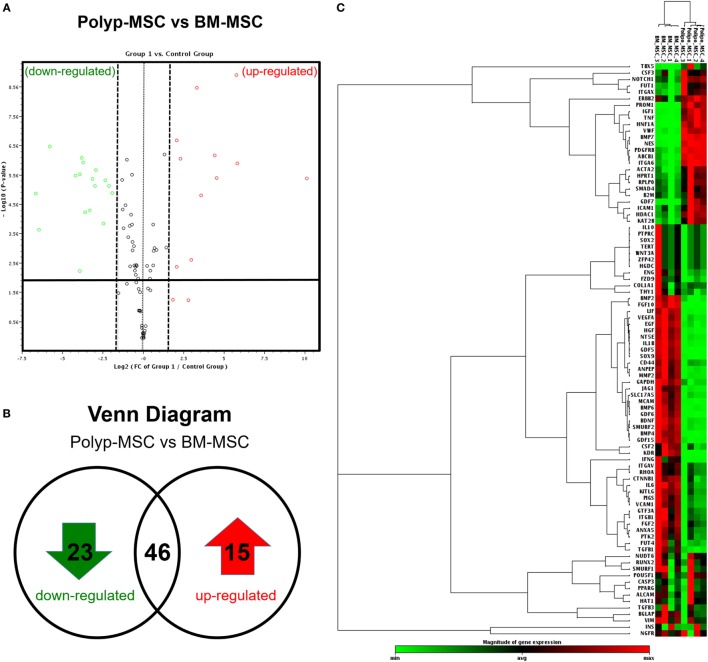
Global gene expression profile. (A) Volcano-plot graph showing the most representative upregulated (red) and downregulated (green) genes in Polyp-MSC (PO-MSC) in comparison with bone marrow-derived MSC (BM-MSC); (B) Venn diagram illustrating the number of upregulated/downregulated genes; and (C) heat map-cluster analysis demonstrating a global difference in gene expression, as well as the most representative clusters of samples and genes. Interestingly, there were several modulated genes in the comparison of PO-MSCs versus BM-MSCs, and the mesenchymal stromal cells from each tissue (Polyp and bone marrow) showed a different profile, being grouped in the same group.